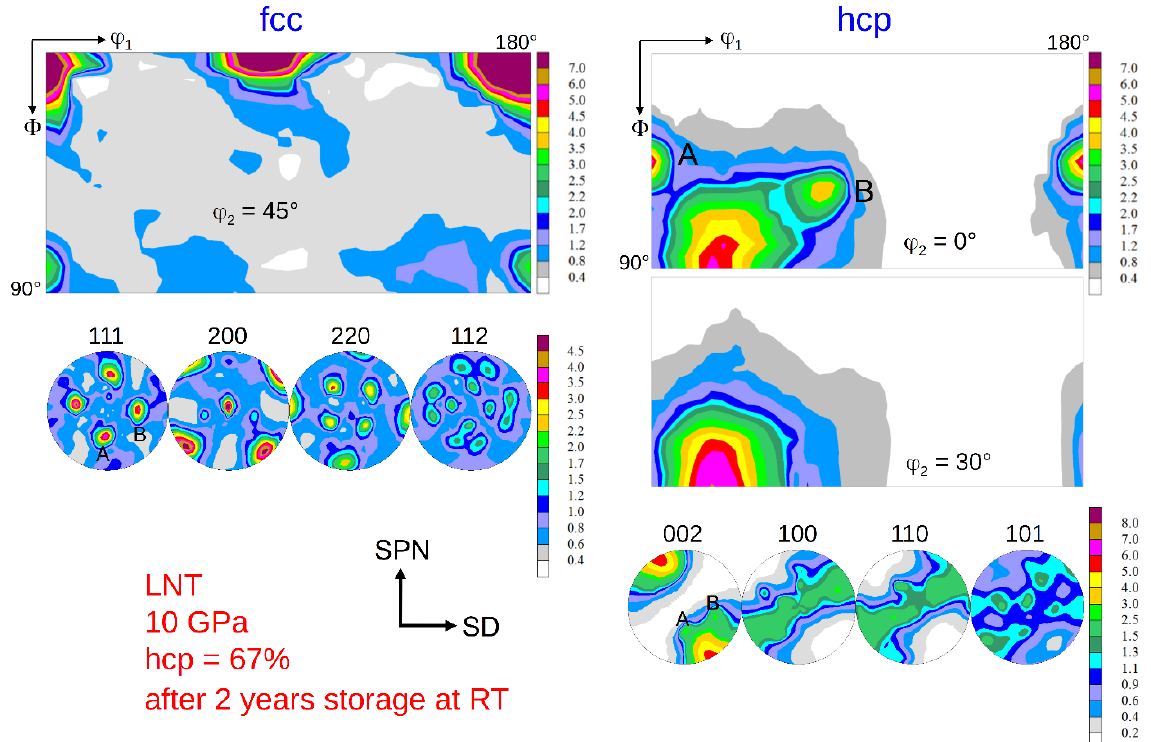
Figure 12. Texture of the fcc and hcp phase after HPT at LNT at 10 GPa pressure and a shear strain γ = 94 after 2 years storage at ambient conditions. The remaining hcp volume fraction is 67%. The two hcp recrystallization and/or grain growth components are marked A and B in the ODF and the (002) hcp PF. The related components in the fcc phase are also marked in the (111) fcc PF. (for key figures and designation of the fcc and hcp shear texture components see Figures 7 and 13,